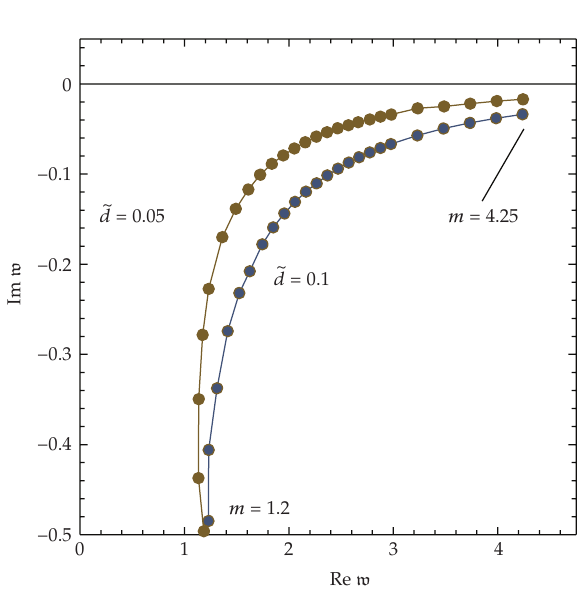
Figure 14: The trajectory of the quasinormal mode with lowest | w | in the complex w -plane parametrized by the quark mass parameter m . for Re w < 3 successive points have Δ m (cid:5) 0 . 1, for Re w > 3 we chose Δ m (cid:5) 0 .